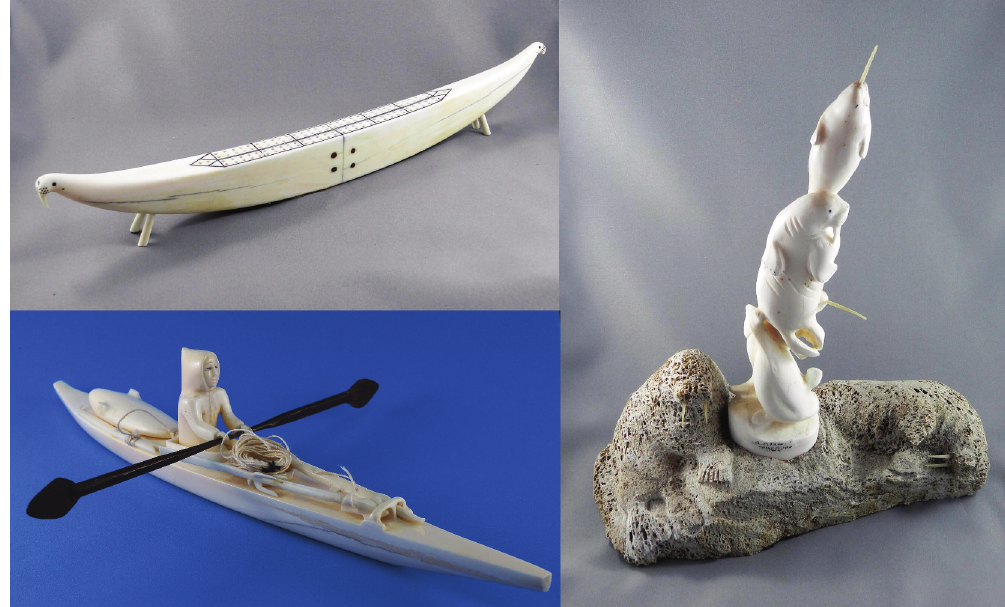
Fig. 10. Examples of walrus ivory carvings including a cribbage board ca. 1930 (upper left), a fine recent sculpture by A. Pijamini of Grise Fiord (right), and a kayak (date unknown; lower left) (authors’